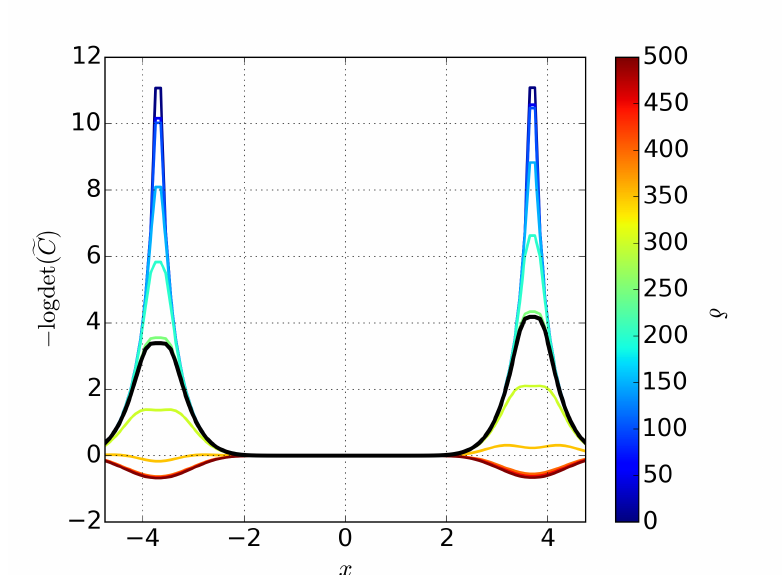
Figure 2. Variation of the regularization parameter δ and its influence on the exploration